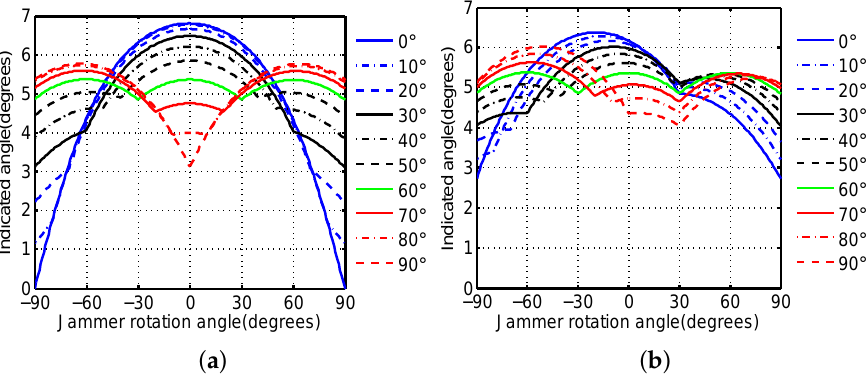
Figure 11. Monopulse-indicated angles for different configurations when the jammer antennas rotate. The system parameters are a 1 = a 2 = a 3 = − 0.5 dB, φ 1 = φ 2 = φ 3 = 180 ◦ . ( a ) Symmetrical case. ( b ) Asymmetrical